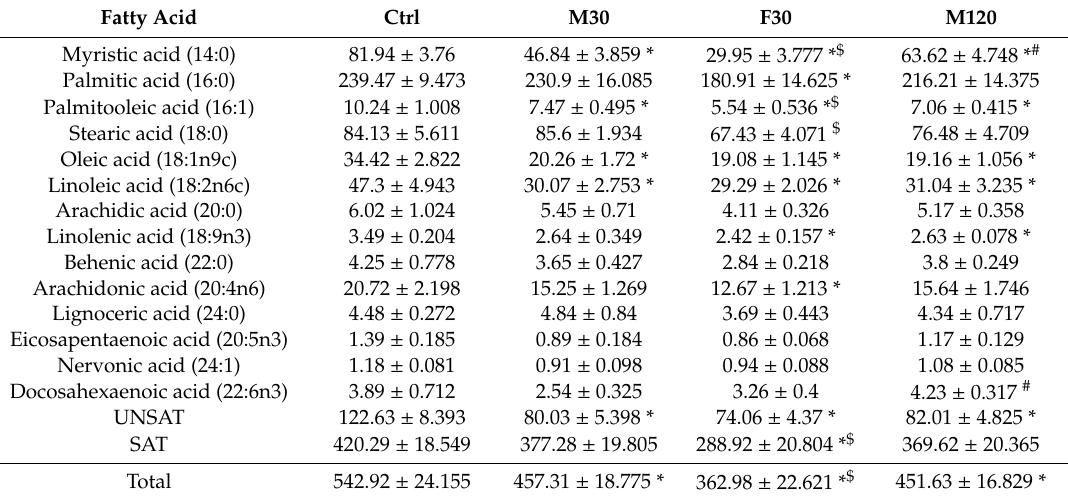
Table A5. The right ventricle DG—fatty acid composition (nmol / g of wet tissue).